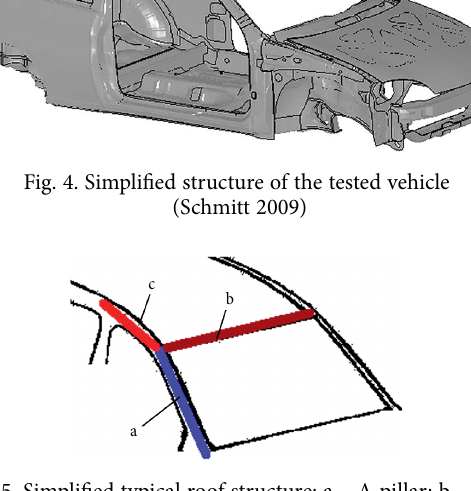
Fig. 5. Simplified typical roof structure: a – A-pillar; b – roof front header; c – roof side rails (Dzerkelis, Bazaras